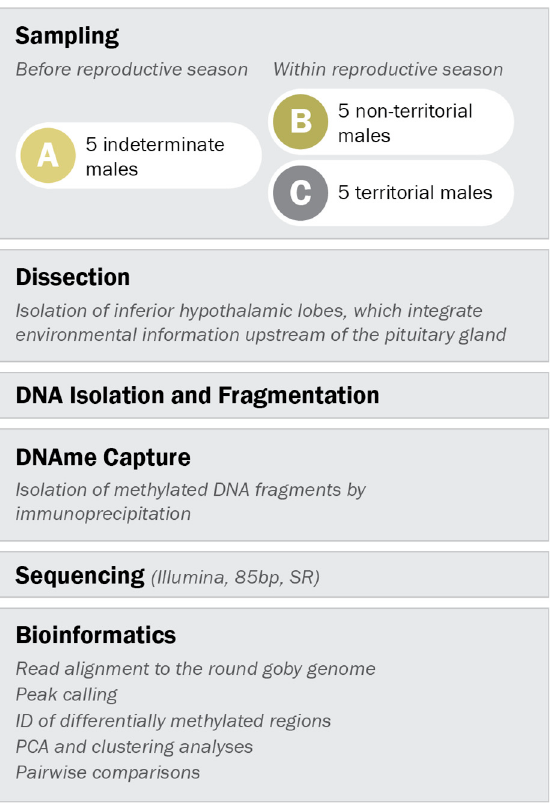
Figure 2. Experimental setup. Indeterminate males were sampled before the reproductive season, while males with non-territorial and territorial phenotype were sampled within the reproductive season. DNA methylation patterns in the inferior hypothalamic lobes were analyzed according to the outlined procedure.